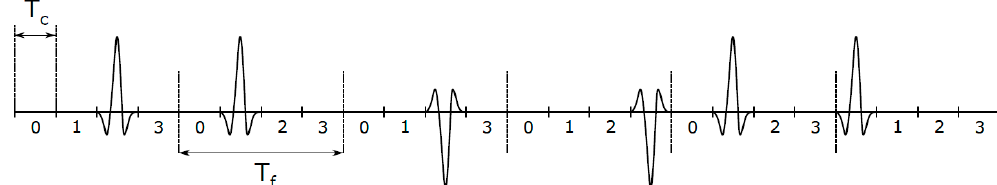
Figure 2. Impulse radio ultra-wideband (IR-UWB) signals in the time domain.